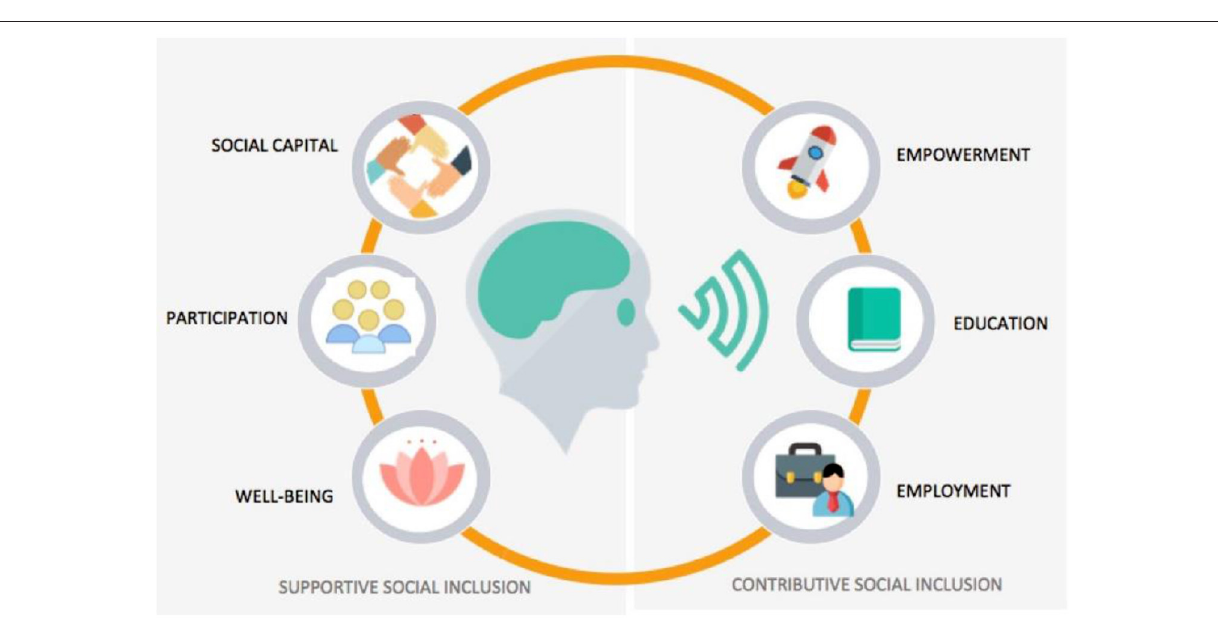
FIGURE 4 | A “GazeTheWeb” model of supportive and contributive social inclusion